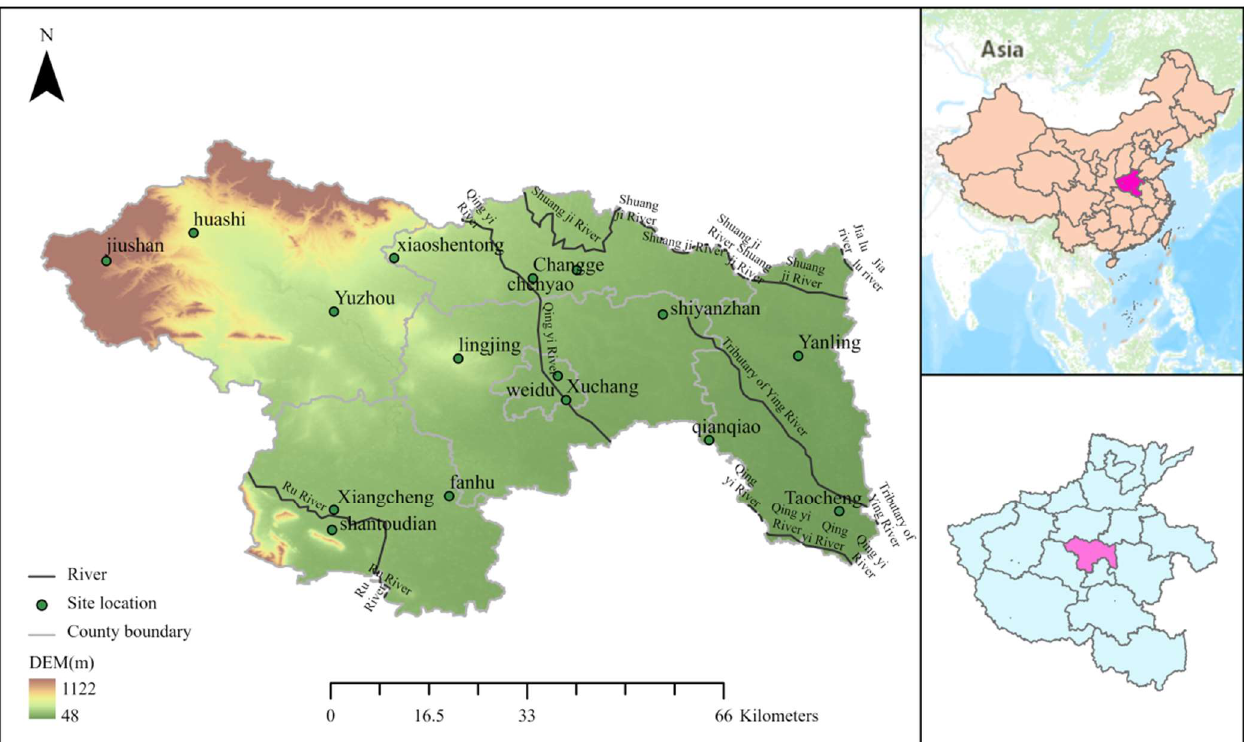
Figure 1. Distributions of spatial elevation, meteorological stations and rivers of research region.